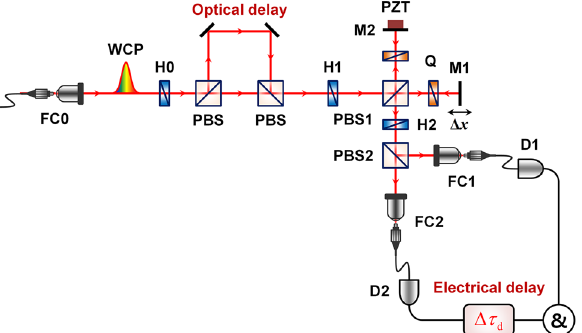
Figure 7. Experimental setup to observe the two-photon interference of temporally separated weak coherent pulses. Temporal separation between two sequential pulses is introduced by applying an optical delay, and the temporal post-selection of the interfering two-photon states is performed by the application of an electrical delay ( �τ d ) and a variable coincidence time window. (cid:31) x is used for varying the path-length difference between the two interferometer arms to observe interference